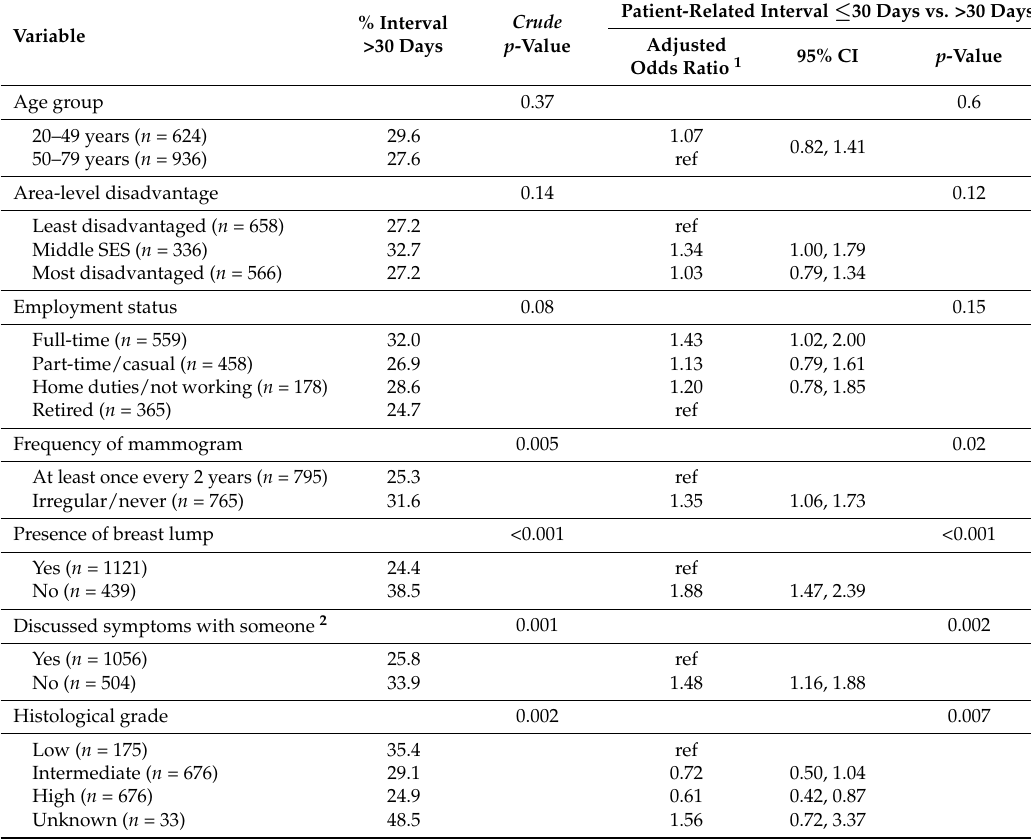
Table 2. Multivariable logistic regression model showing factors associated with patient-related interval for 1560 women with symptom-detected breast